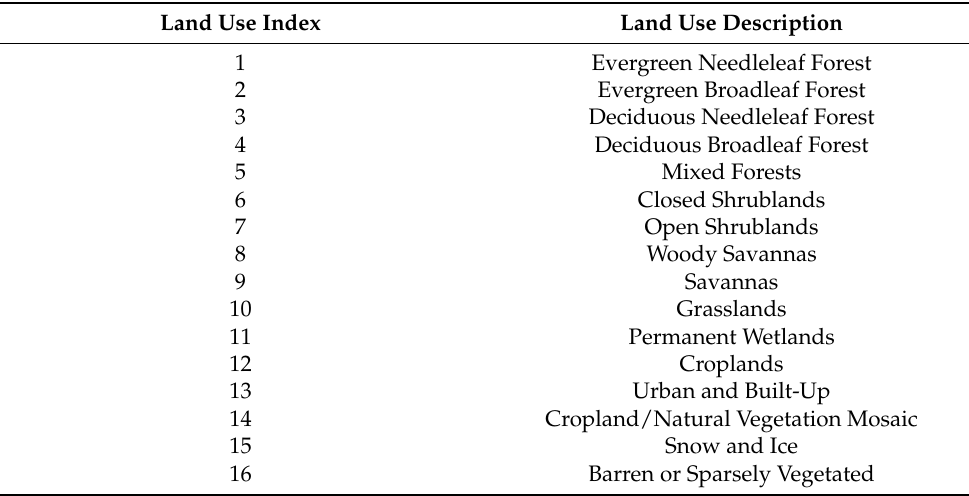
Figure 3. TCEQ stations collocated on the WRF model’s resolved static data: ( a ) IGBP MODIS land-use index; ( b ) urban fraction ( λ u ); ( c ) building height weighted by plan area; ( d ) building plan area fraction ( λ p ); ( e ) BEP’s constant drag coefficient, and ( f ) BEP’s new drag coefficient. Table 3. Modified IGBP MODIS Noah land use indices and